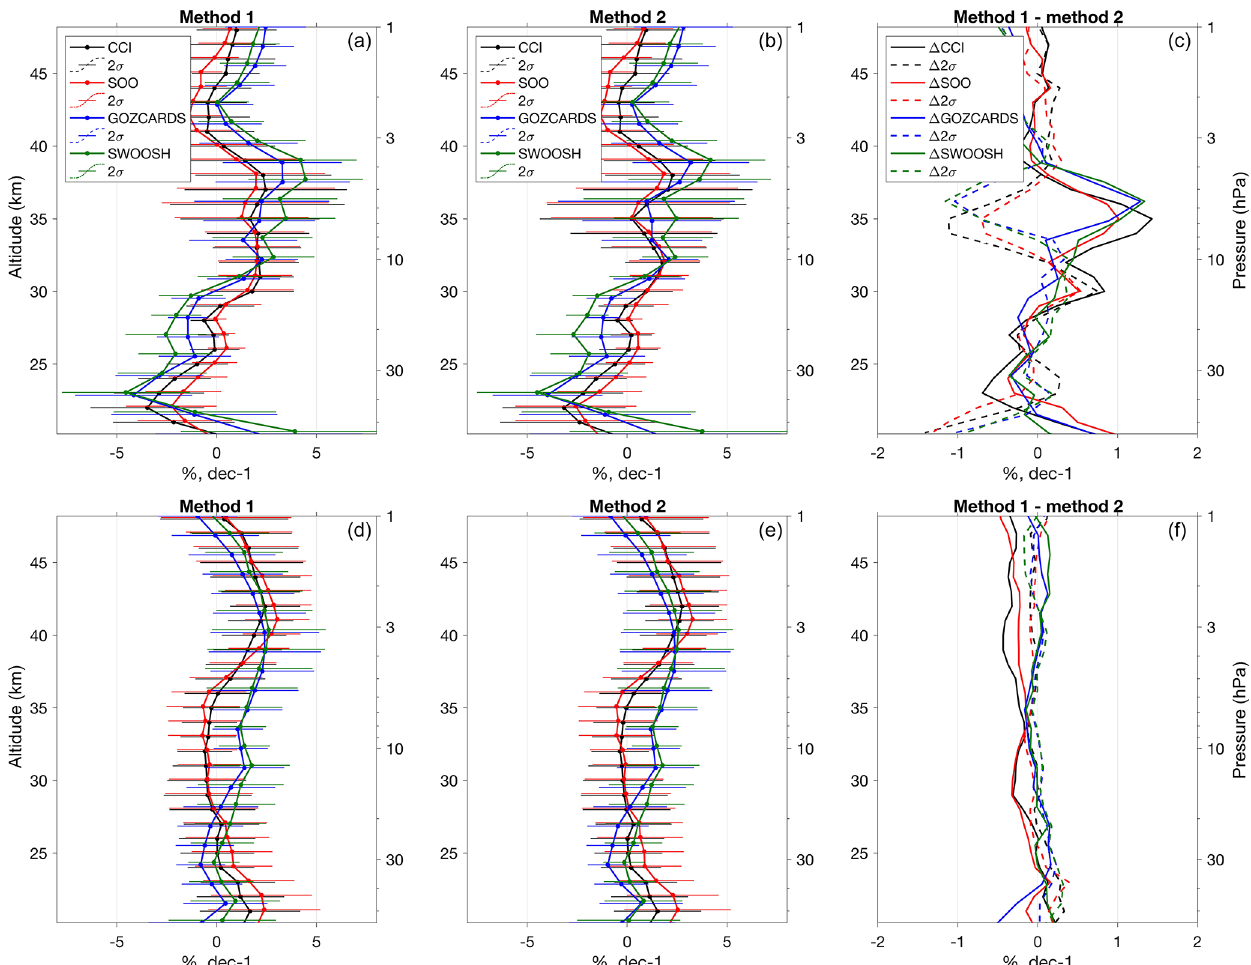
Figure 2. Vertical profiles of ozone trends in 2000–2018 from CCI (black), SOO (red), GOZCARDS (blue), and SWOOSH (green). The results are shown for March, latitudinal bands 10 ◦ S–10 ◦ N (a, b) and 30–60 ◦ N (d, e) for two separate methods (see description in the text). Error bars are 2 σ uncertainties. Data are presented on their natural vertical coordinate: altitude grid (left axis) for CCI and SOO and pressure grid (right axis) for GOZCARDS and SWOOSH. Panels (c) and f) show the difference between methods for trends (solid lines) and uncertainties (dashed